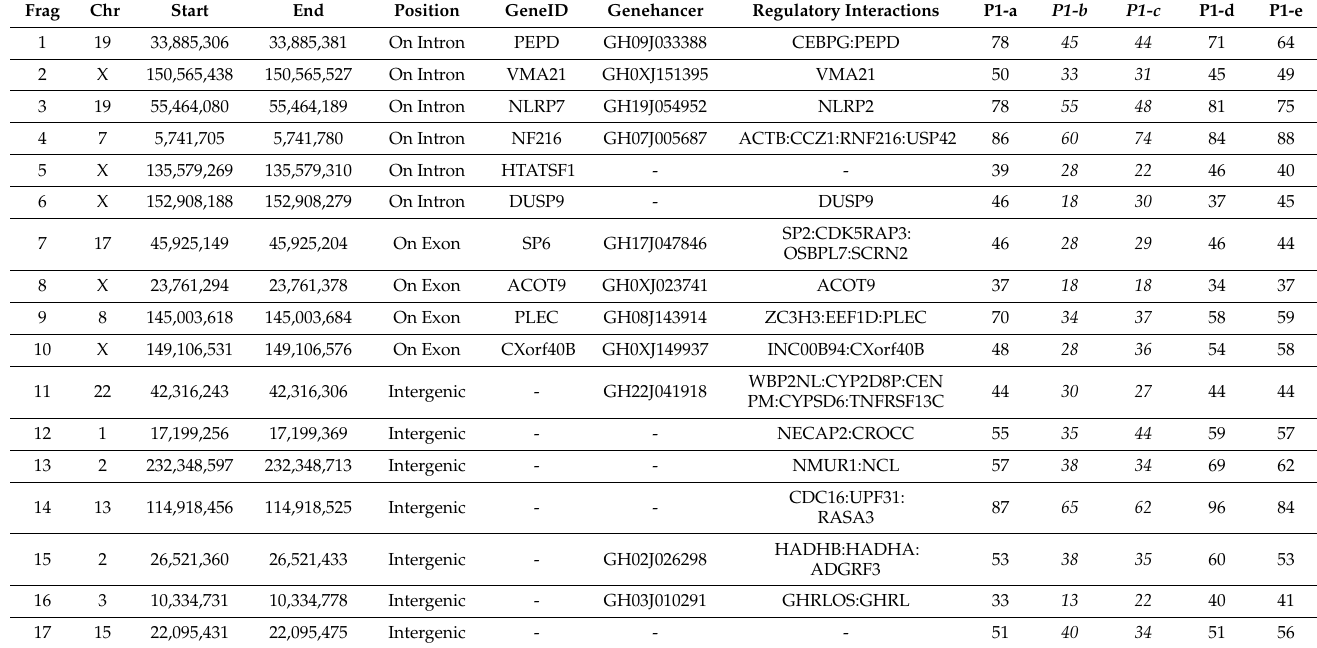
Table 1. Fragments associated with the relapse condition for P1. Fragments with a Pearson’s correlation coefficient of at least 0.9 and a mean methylation difference between the “relapse” and “recovery” time points of at least 15% are shown. The table describes the location of each fragment, and the gene id if appropriate. It lists any overlapping regulatory elements (promoters/enhancers) recorded in Genehancer and the gene id associated with clusters of regulatory interaction determined using UCSC genome browser. Additionally, the table shows the methylation percent recorded for each time point (P1- a to P1- e ) at each fragment with the relapse time points